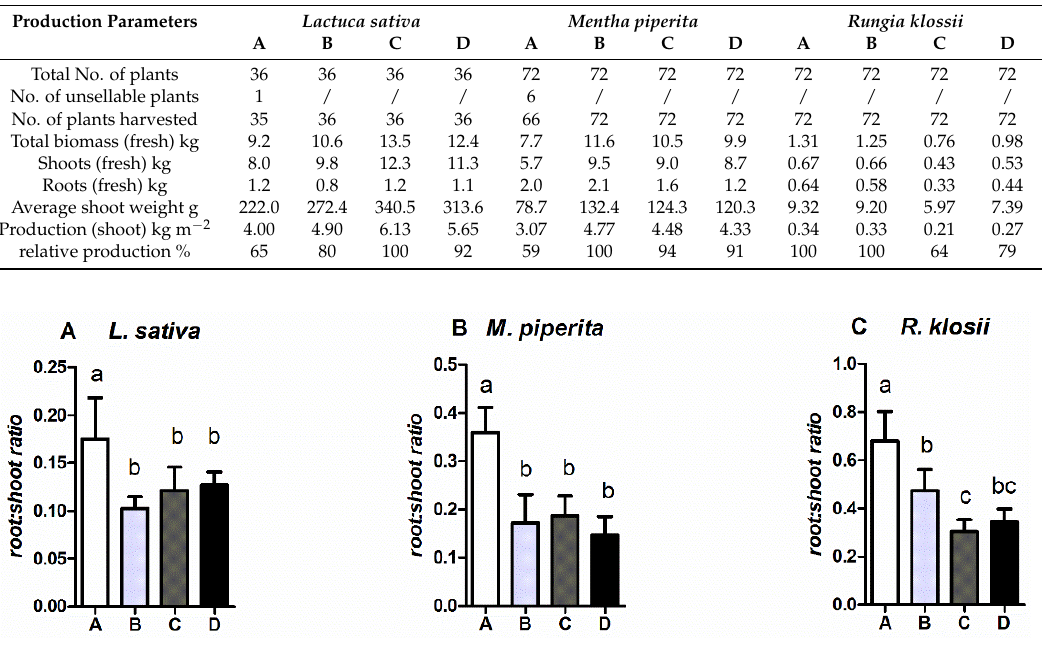
Table 3. Fresh biomass at harvest for the production of lettuce, mint, and mushroom herbs in all of the systems. Relative production was calculated separately as the fraction of the highest production value for each species.